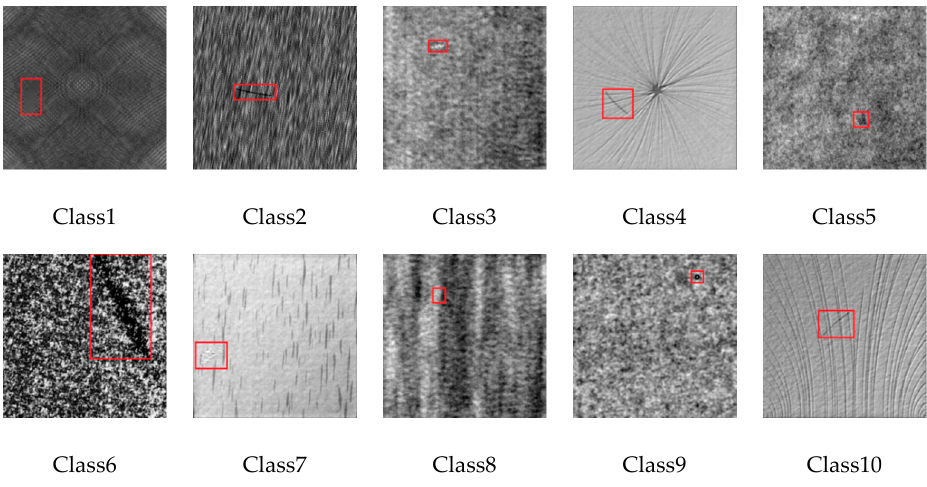
Figure 9. Illustration of images on DAGM2007 Dataset